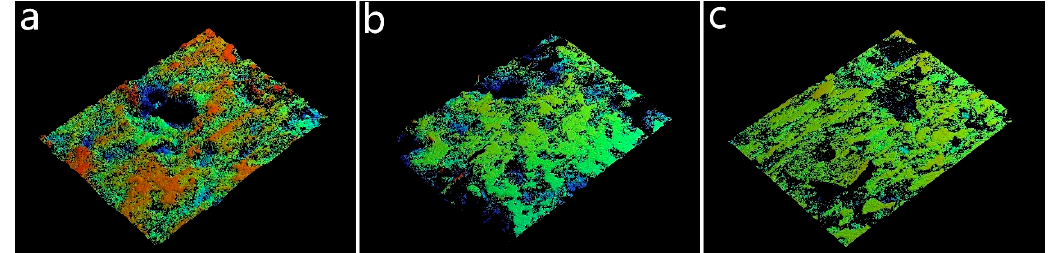
Figure 9. Three-dimensional surface morphology photos of different types of brake pads; ( a ) semi-metallic brake pads; ( b ) organic asbestos-free brake pads; ( c ) ceramic brake pads.